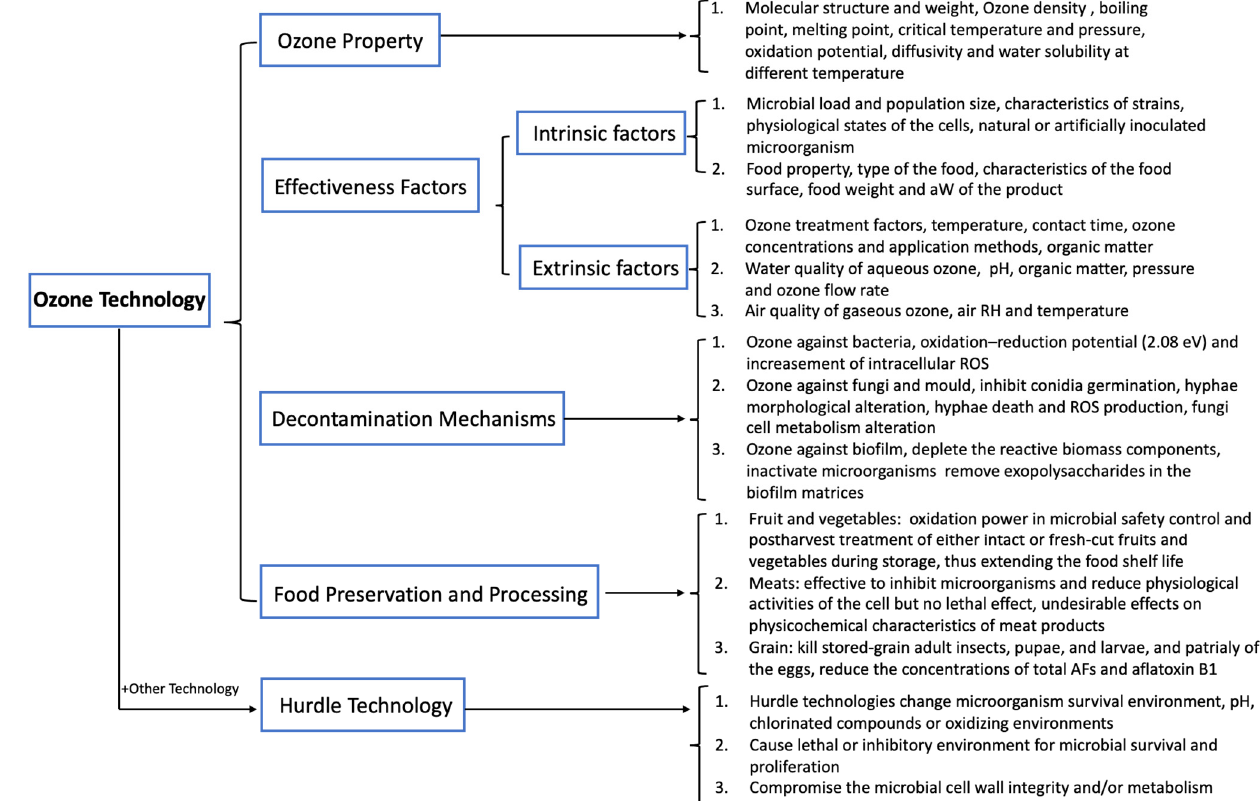
Figure 2. A flowchart to summarise the review studies of ozone technology.